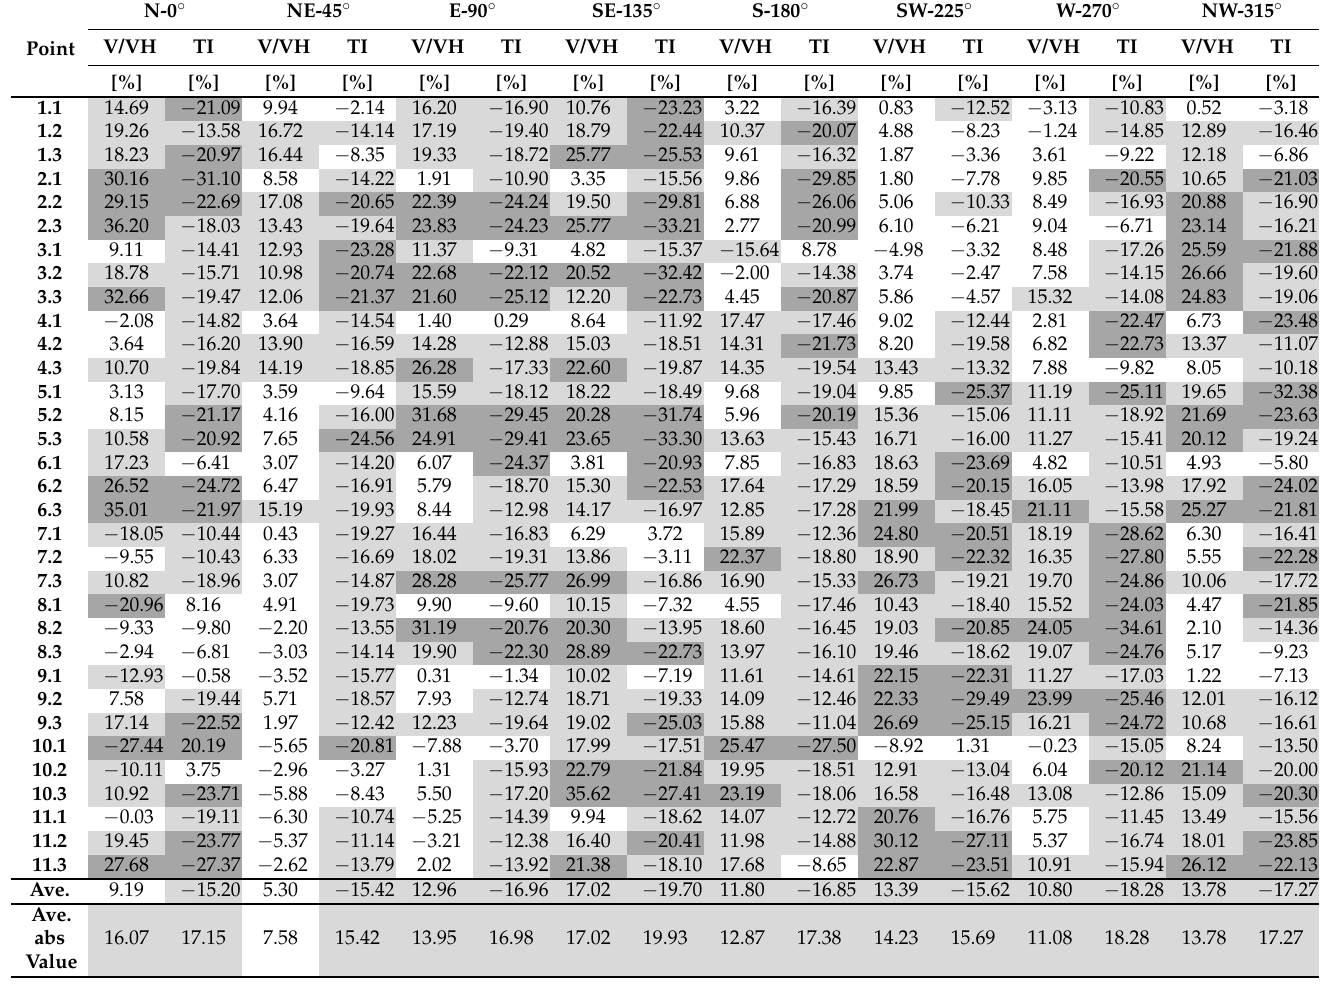
Table 9. OpenFOAM deviation results. V/VH is the ratio between velocity (V) and velocity at the top of the boundary layer achieved by the model (VH); TI is the turbulence intensity. Values shadowed by dark grey represent deviations with values ≥ 20% or ≤ − 20% while values shadowed by light grey color represent deviation values ≥ 10% or ≤− 10% and no shadowed values have deviation values > − 10% or values < 10%. Points denoted by .1 or .2 or .3 mean height above ground at 9 m, 12 m, and 17 m,